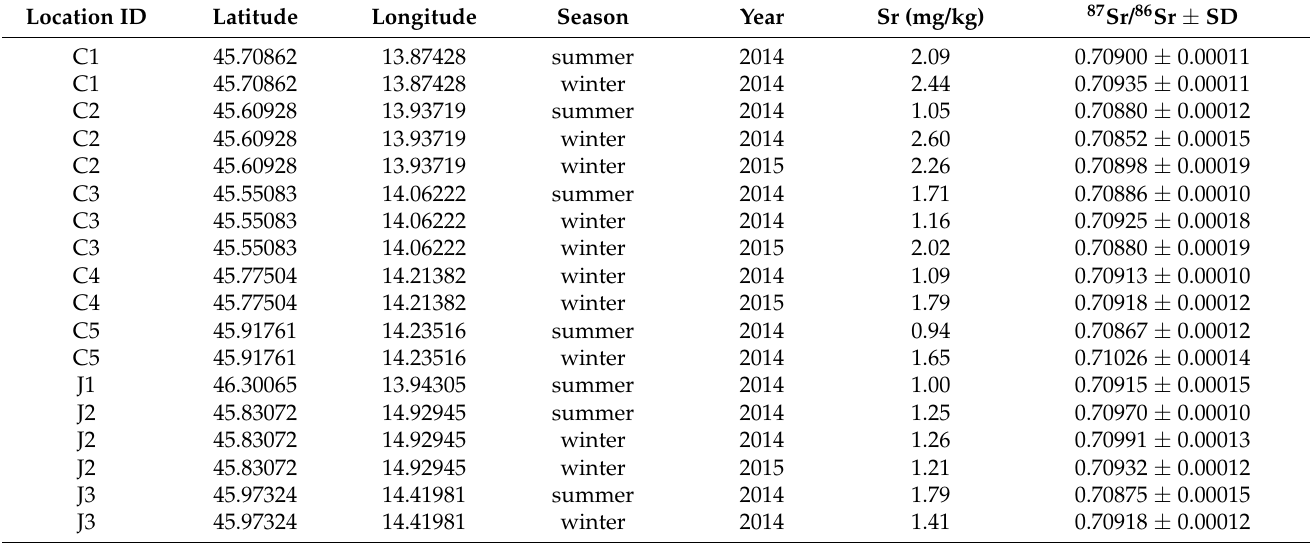
Table 1. Sample ID, latitude, longitude, season and year of sampling together with the content of Sr determined by ICP-MS and 87 Sr/ 86 Sr ratios in authentic milk samples. SD values are the standard deviations between samples from different farms at the same or nearby